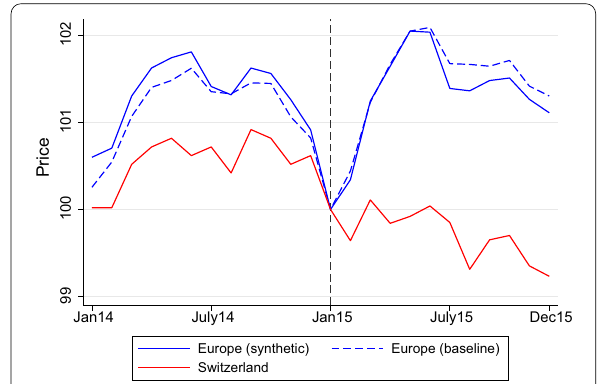
Fig. 4 Synthetic control group prices. Notes Monthly HICP all-items index with January 2014 prices normalized to 100. Europe (baseline) is a GDP-weighted price average of 33 European countries excluding Switzerland. Europe (synthetic) is the control group implied by the synthetic DID method of Arkhangelsky et al. (2021), using the same sample of 33 European countries but excluding for the 10 countries with the most volatile prices in 2015. Data source: Eurostat